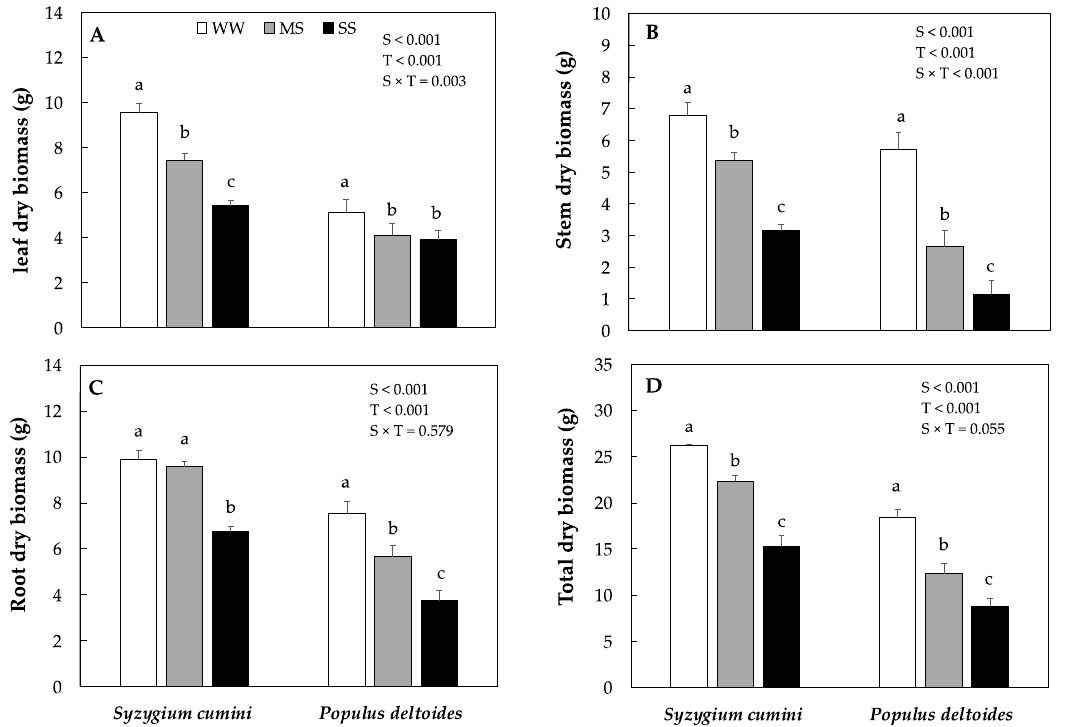
Figure 1. Means dry biomass production of in leaf dry biomass ( A ), stem dry biomass ( B ), root dry biomass ( C ), and total dry biomass ( D ) under different level of water deficit treatment in Syzygium cumini and Populus deltoides . The traits were tested using a two ‐ way ANOVA for species effect (S ‐ effects), treatment effect (T ‐ effects) and interaction effects (S × T). Values represent the means (±SE) in various treatments. Small letters represent significant difference between treatments within each species tested using the Dunnett’s test. All the tests were taken to be significant at p < 0.05.